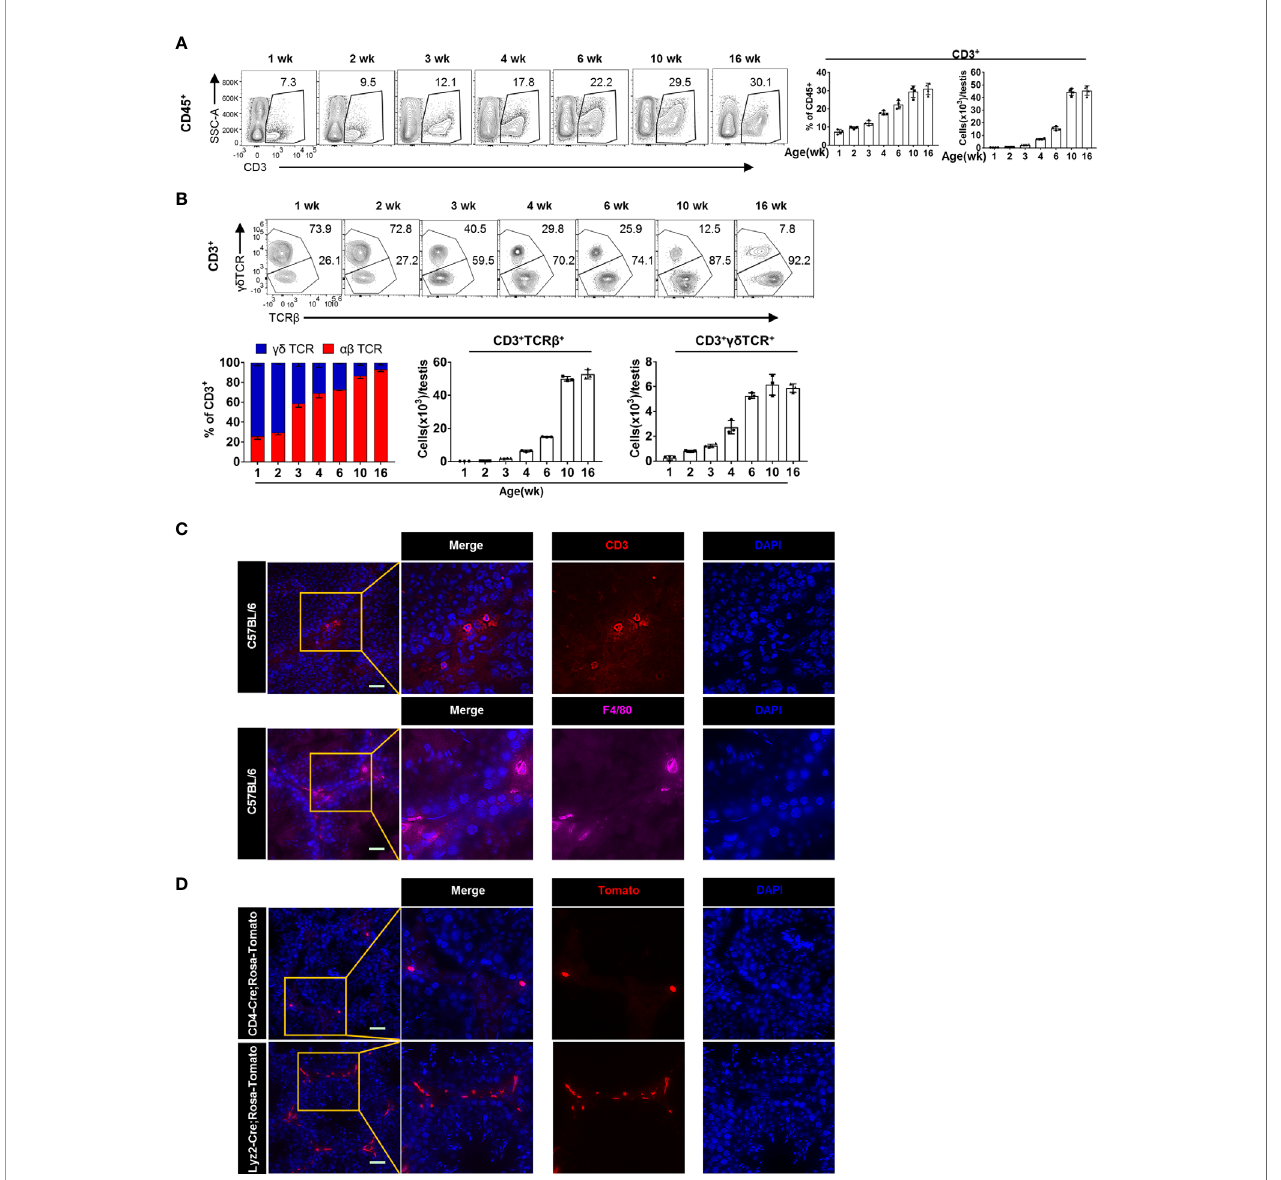
FIGURE 2 | The dynamic changes and localization of T cells in postnatal testis. (A) FACS analysis of the frequency and number of T cells (CD3 + ) in the testis from the 1-, 2-, 3-, 4-, 6-, 10-, and 16-week-old C57BL/6 mice. (B) FACS analysis of the frequency and number of gd TCR + (CD3 + gd TCR + ) and ab TCR + (CD3 + TCR b + ) T cells in the testis from the 1-, 2-, 3-, 4-, 6-, 10-, and 16-week-old C57BL/6 mice. (A, B) n = 4 – 5. Data are representative of two experiments. Error bars are the mean ± SD. (C) Microscopic analyses of CD3 and F4/80 in frozen sections of the testis from 10-week-old C57BL/6 mice. (D) Frozen sections of the testis from CD4-Cre ; Rosa-Tomato mice and Lyzm2-Cre ; Rosa-Tomato mice. Expression of Tomato protein represents T cells and macrophages, respectively. (C, D) Scale bars: 50 m